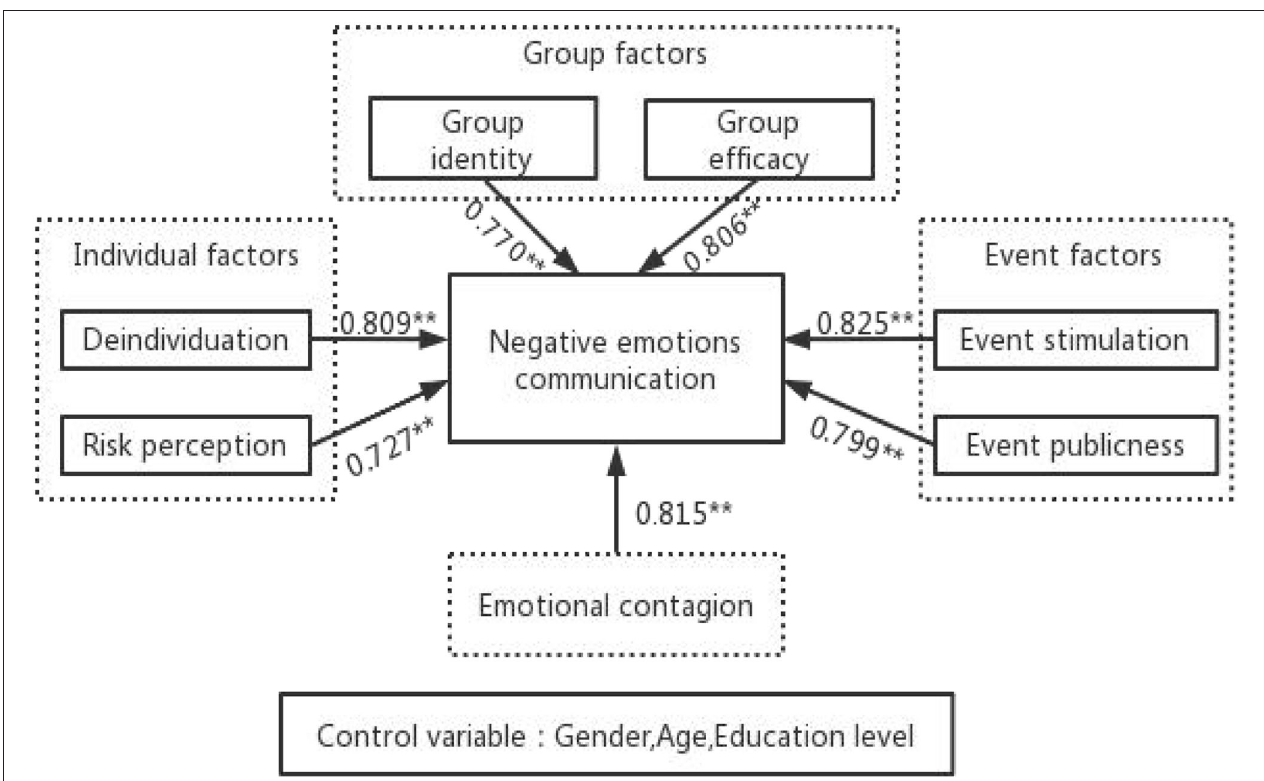
FIGURE 4 | Model of the influencing factors on negative emotions communication. ** p <